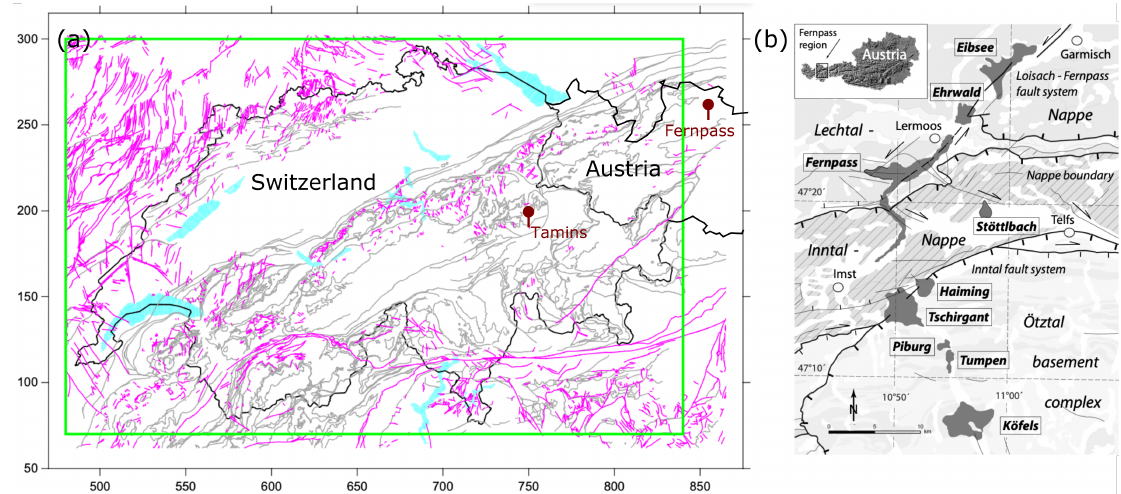
Figure A1. ( a ) Map view of the fault database held by the Swiss Federal Office of Topography, adapted from [29]. Supposedly-active and supposedly-inactive faults are, respectively, coloured in magenta and grey. ( b ) Main geological structures of the Fernpass region (Tyrol, Austria) highlighting thrust sheet units and deep-seated rockslide deposits (coloured in dark grey) and the left-lateral strike-slip fault system located in the east of the Fernpass source area (extracted from [16].)